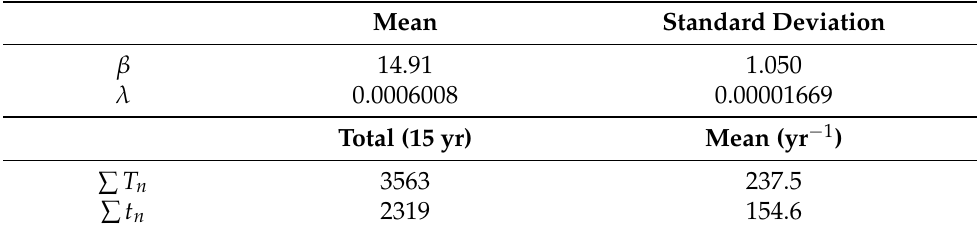
Table 1. Posterior parameters and model predictions.